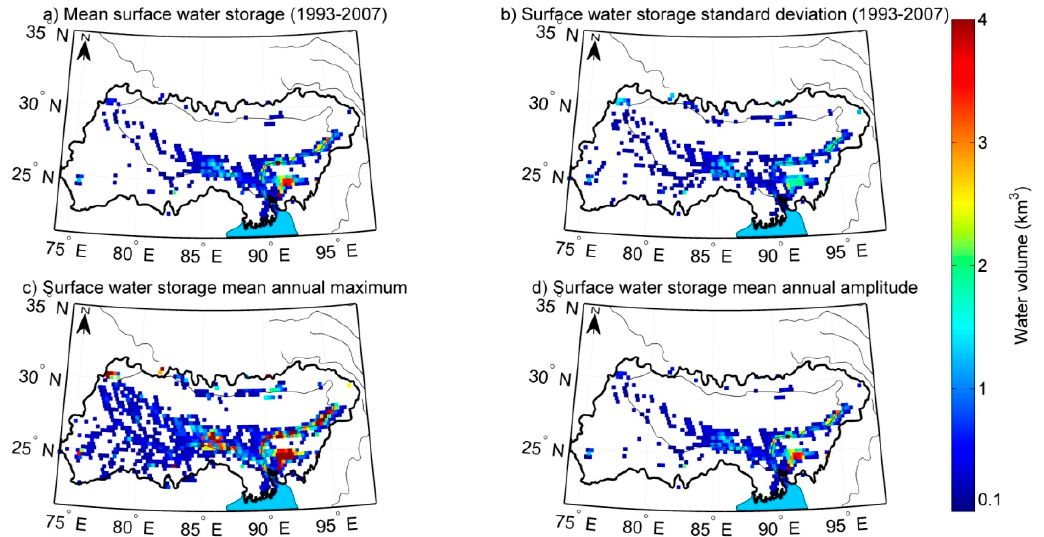
Figure 5. Main characteristics of the surface water storage (SWS) spatial distribution provided by the hypsographic curve approach (GIEMS/ASTER): ( a ) Mean surface water storage over the 1993–2007 period; ( b ) Associated standard deviation; ( c ) Mean annual maximum of SWS; ( d ) Mean annual amplitudes of SWS. It should be noted that water volumes below 0.1 km 3 are not shown in this figure.